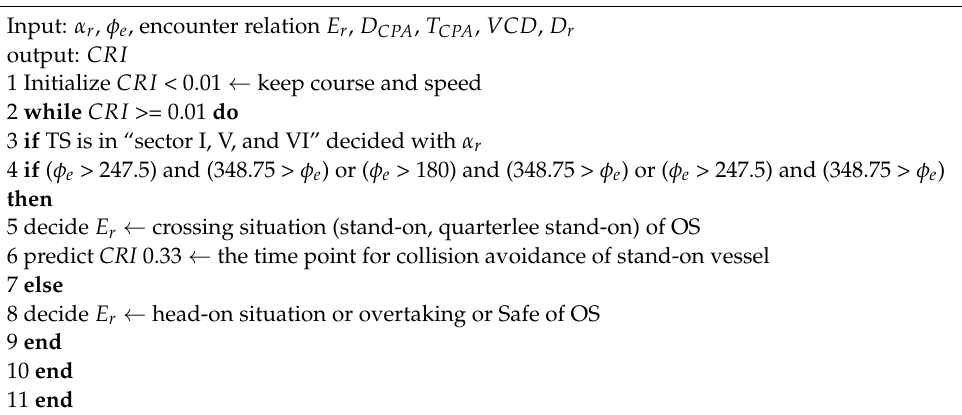
Algorithm 2: Algorithm for developed system